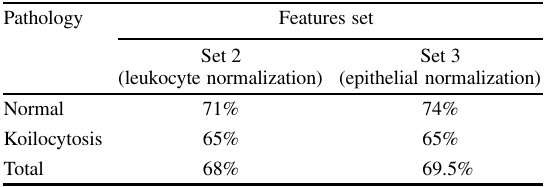
Percentage of correct classification of normal and koilocytosis spec- imen given by stepwise discriminant analysis using features set 2 and 3. F -to-enter: 2